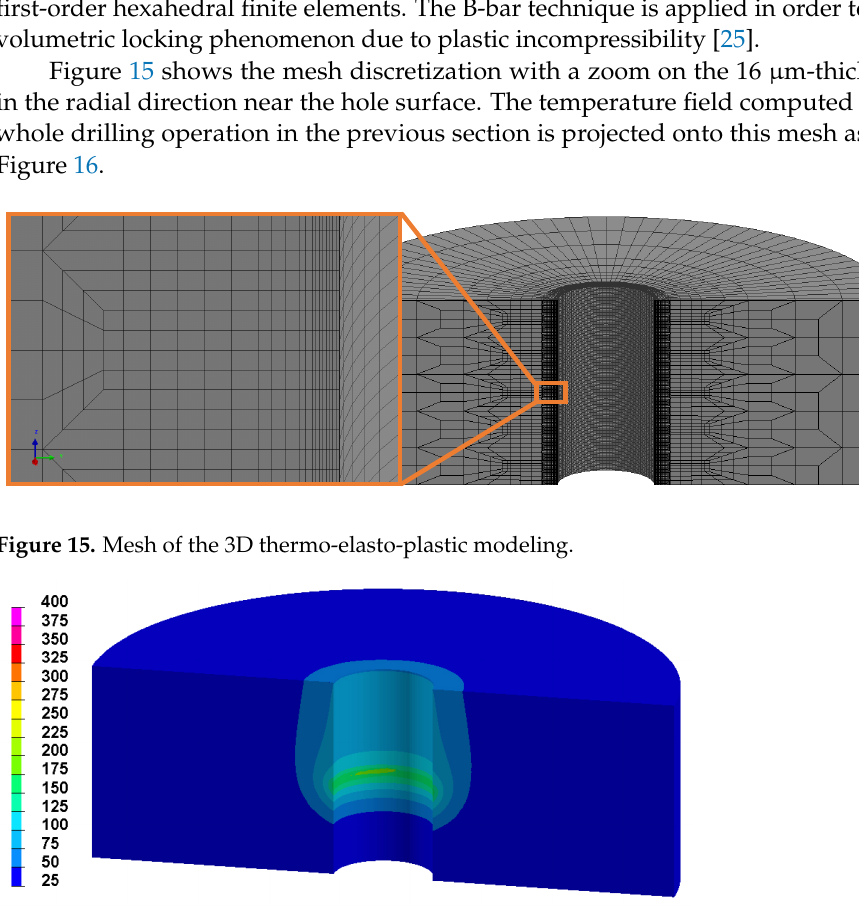
Figure 16. Distribution of temperature ( ◦ C) after